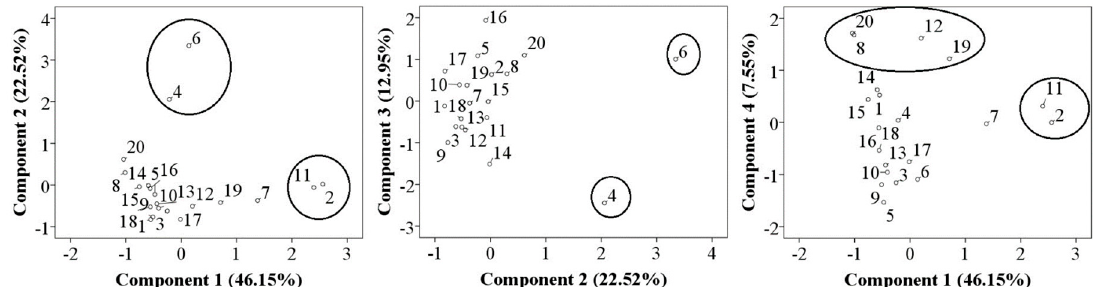
Figure 3. PCA score plots of different Sorbus fruit powder samples. 1—‘Alaja Krupnaja’; 2—‘Burka’;